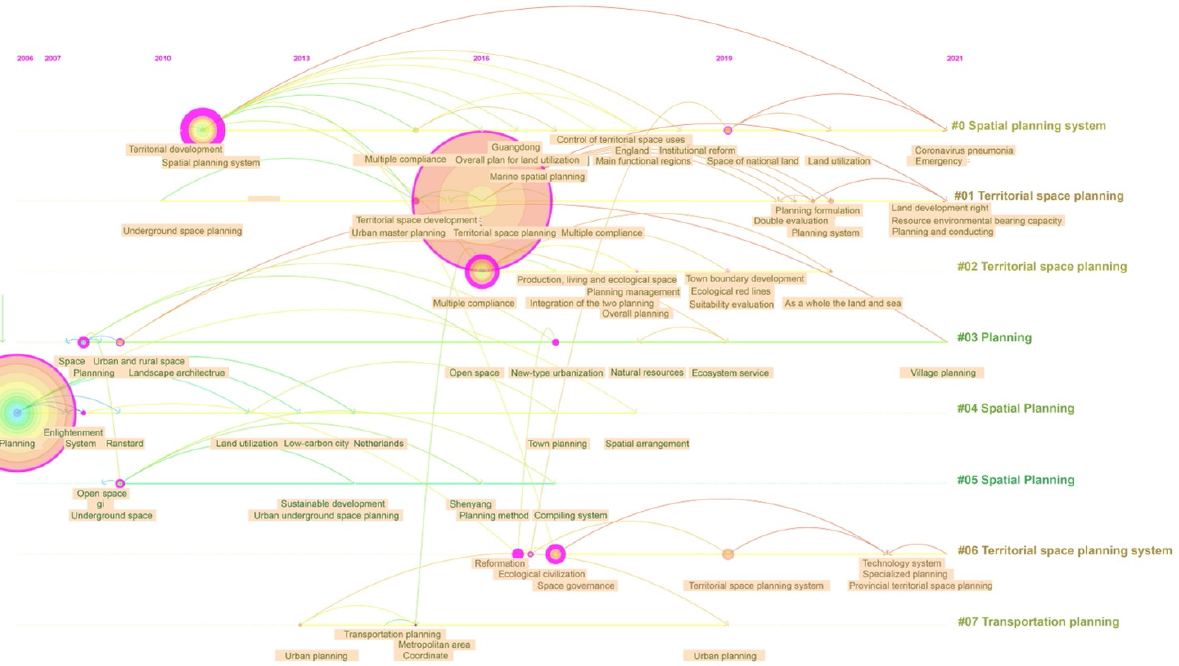
Figure 13. Visualization of the timeline (CNKI database).